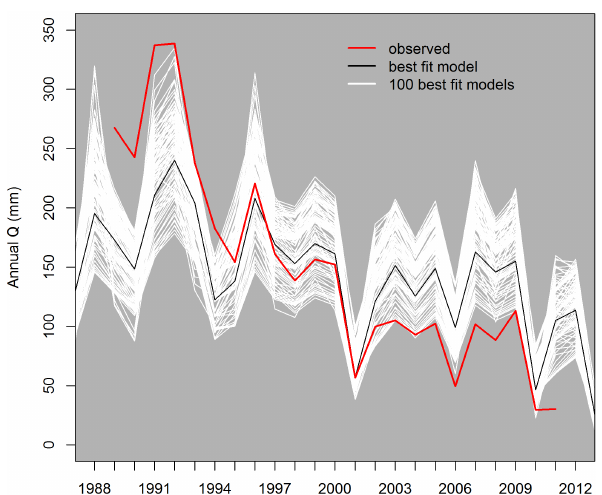
Figure 3. Observed and simulated annual runoff using the S1S model at Bates experimental